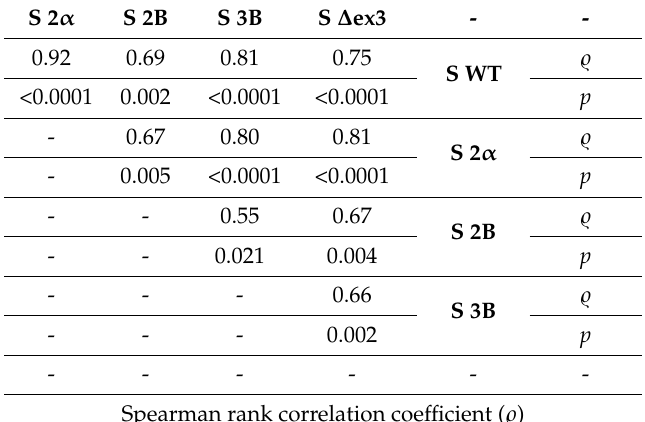
Table 1. The association of survivin isoform expression in OC samples.